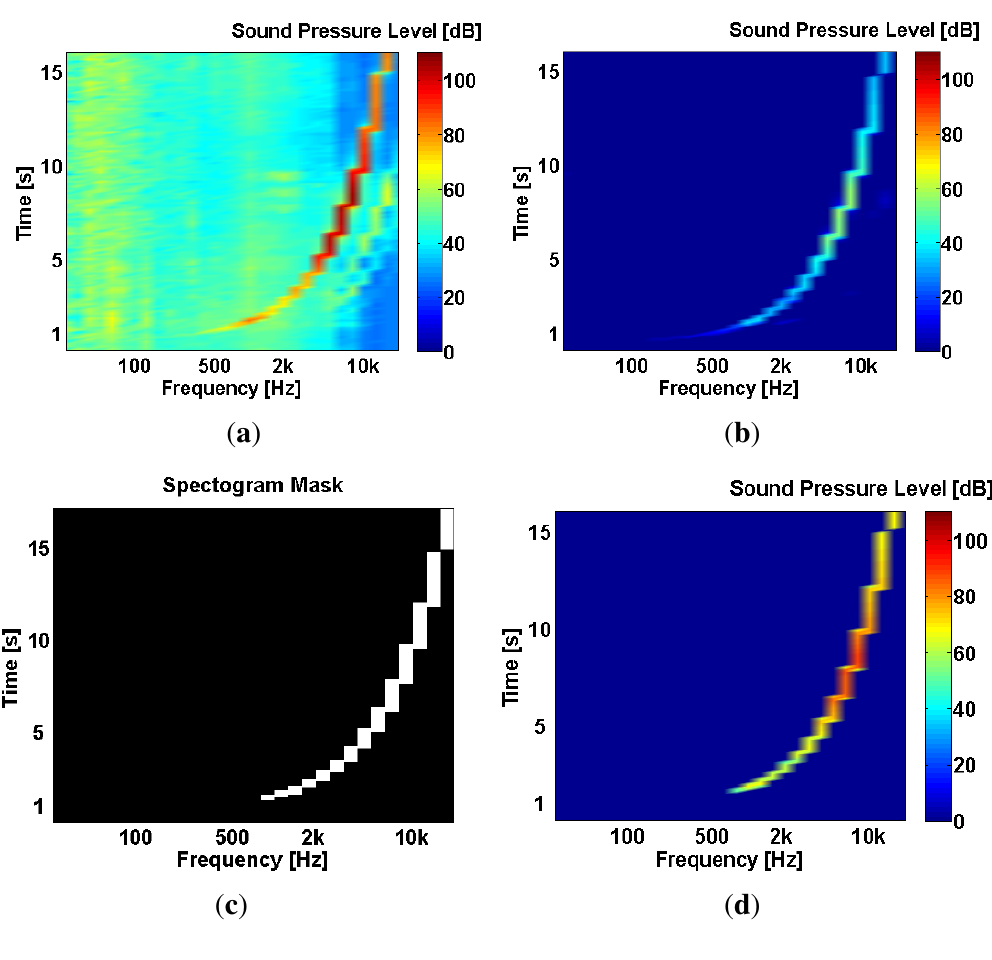
Figure 7. During a self-test, a 16 s frequency sweep is played by the speaker and then captured by the microphone. The microphone’s output is first converted to the frequency domain (1/3 octave bands 8 Hz format) and then sent to the Failure Detection bundle. This bundle extracts the frequency sweep from the background environmental noise in four steps which are shown here in four 16 seconds frequency spectrograms. ( a ) Test output ( T O